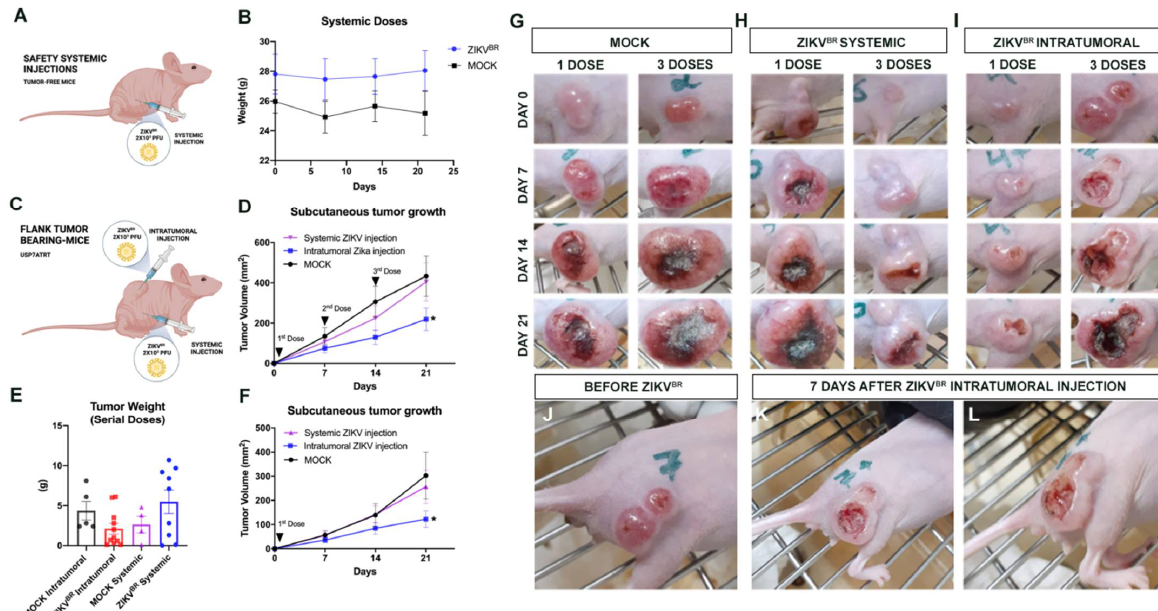
Figure 1. Safety serial systemic ZIKV BR infections and viral tropism. ( A ) Schematic representation of tumor-free mice treated with systemic ZIKV BR injections. ( B ) Weight variation in mice ZIKV BR infected (2 × 10 3 PFU/ZIKV BR ) and control group (PBS) ( n = 8 animals per group). ( C ) Schematic representation of flank tumor-bearing mice treated with systemic or intratumoral ZIKV BR injections. ( D ) USP7ATRT tumor weight variation in the treated group, ZIKV BR systemic or intratumorally injected, and its respective control groups. The tumor volume (mm 3 ) and growth (doubling time (days)) in the control (mock) and ZIKV BR -treated groups, three doses systemic or intratumorally injected ( E ) or ( F ) a single systemic or intratumorally injection. Tumor variation after PBS injection (mock) ( G ), systemic ( H ) or intratumoral ( I ) ZIKV BR single or multiple doses. Tumor establishment ( J ) and regression ( K , L ) observed after ZIKV BR intratumoral injection. * p < 0.05; Student t